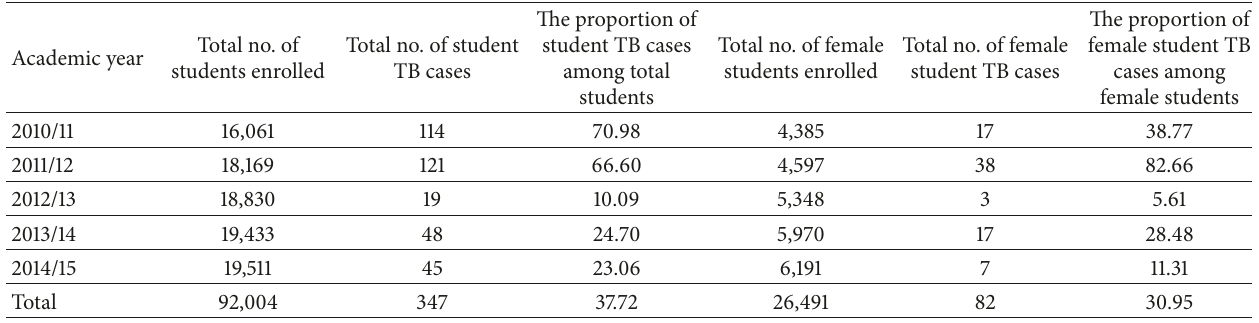
Table 2: The proportion of student TB cases among total students enrolled at Jimma University by academic year, 11 Sep. 2010-10 Sep. 2015 (per 10,000 student population).